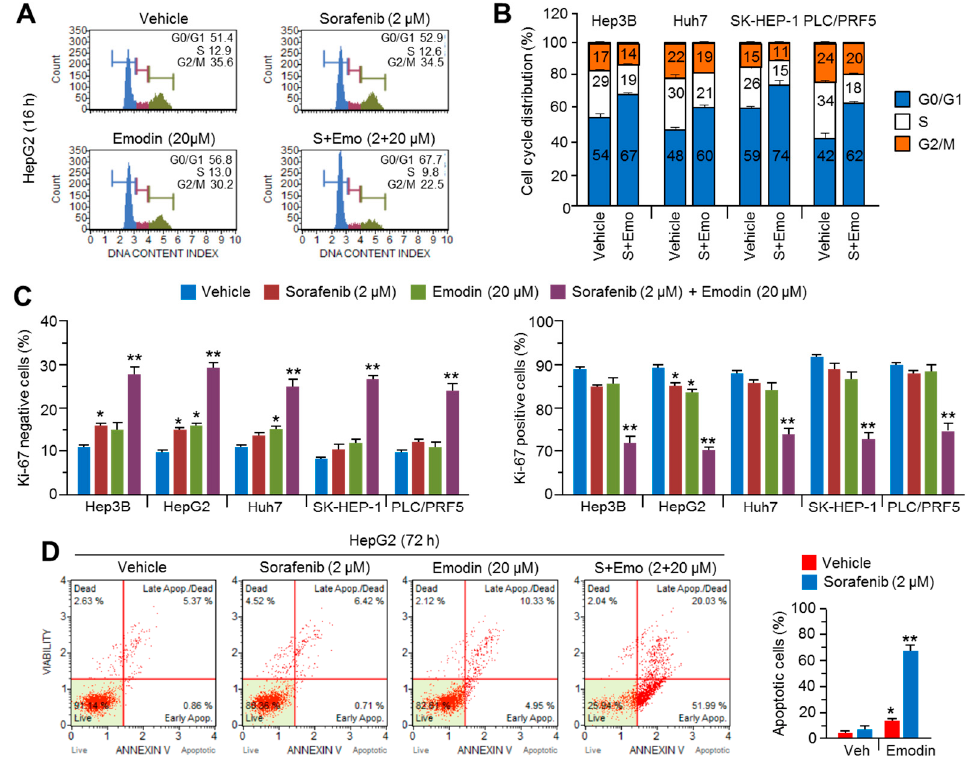
Figure 3. The combination therapy of emodin and sorafenib causes cell cycle arrest and apoptosis in HCC cells. ( A ) The cell cycle analysis after treatment with the combination of emodin and sorafenib in HepG2 cells. ( B ) The cell cycle analysis after treatment with the combination of emodin and sorafenib in Hep3B, Huh7, SK-HEP-1, and PLC/PRF5 cells. The cells were incubated with emodin (20 µ M), sorafenib (2 µ M), or the combination (20 µ M emodin and 2 µ M sorafenib) for 16 h. The values represent the mean ± SEM of three independent experiments performed in duplicate. ( C ) Cell proliferation after treatment with the combination of emodin and sorafenib in five HCC cell lines. The cells were treated with the indicated drugs for 24 h prior to analysis. The values represent the mean ± SEM of three independent experiments performed in duplicate. ( D ) The induction of apoptosis after treatment with the combination of emodin and sorafenib in HepG2 cells. The cells were incubated with emodin and sorafenib for 72 h. The values represent the mean ± SEM of three independent experiments performed in duplicate; * p < 0.05 and ** p < 0.01.